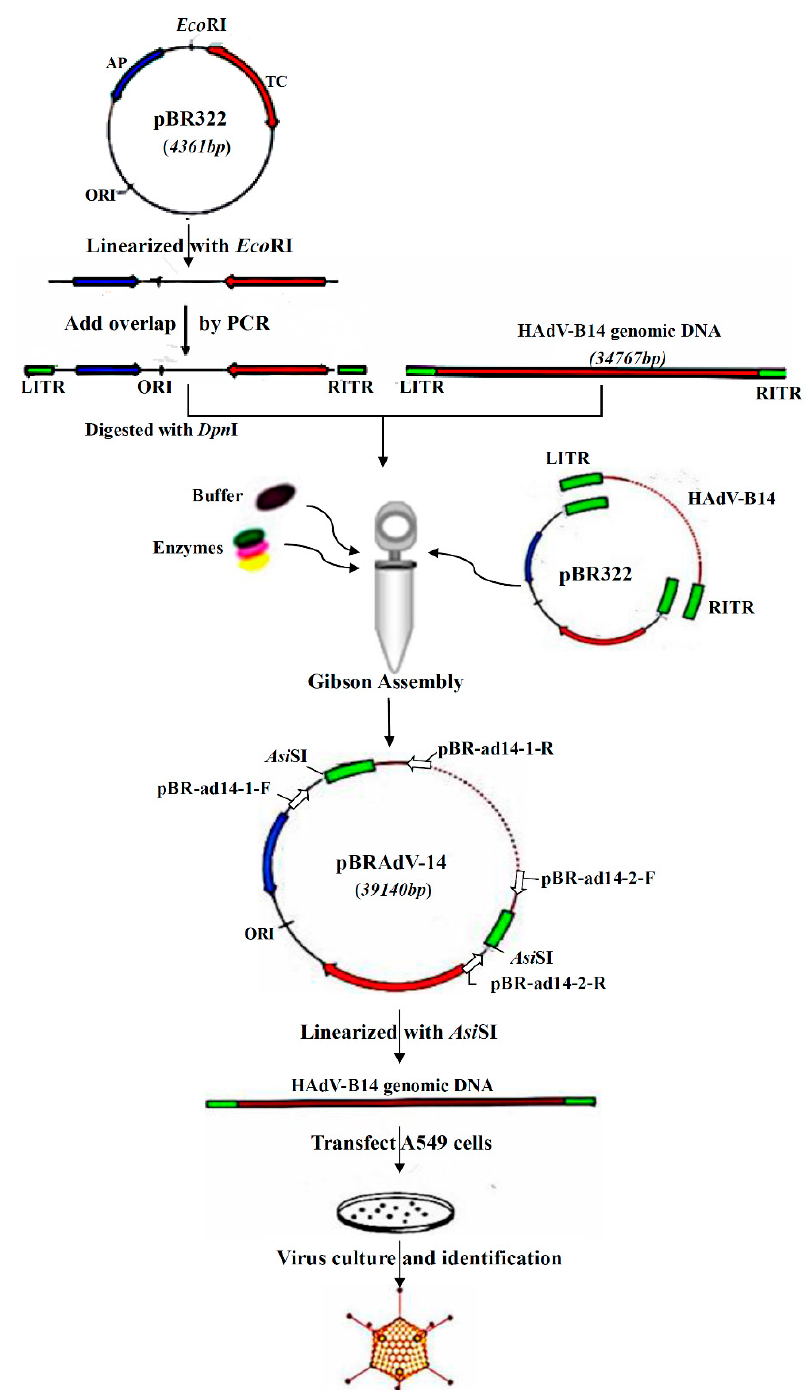
Figure 1. The schematic diagram of the construction of an infectious clone of HAdV-B14.